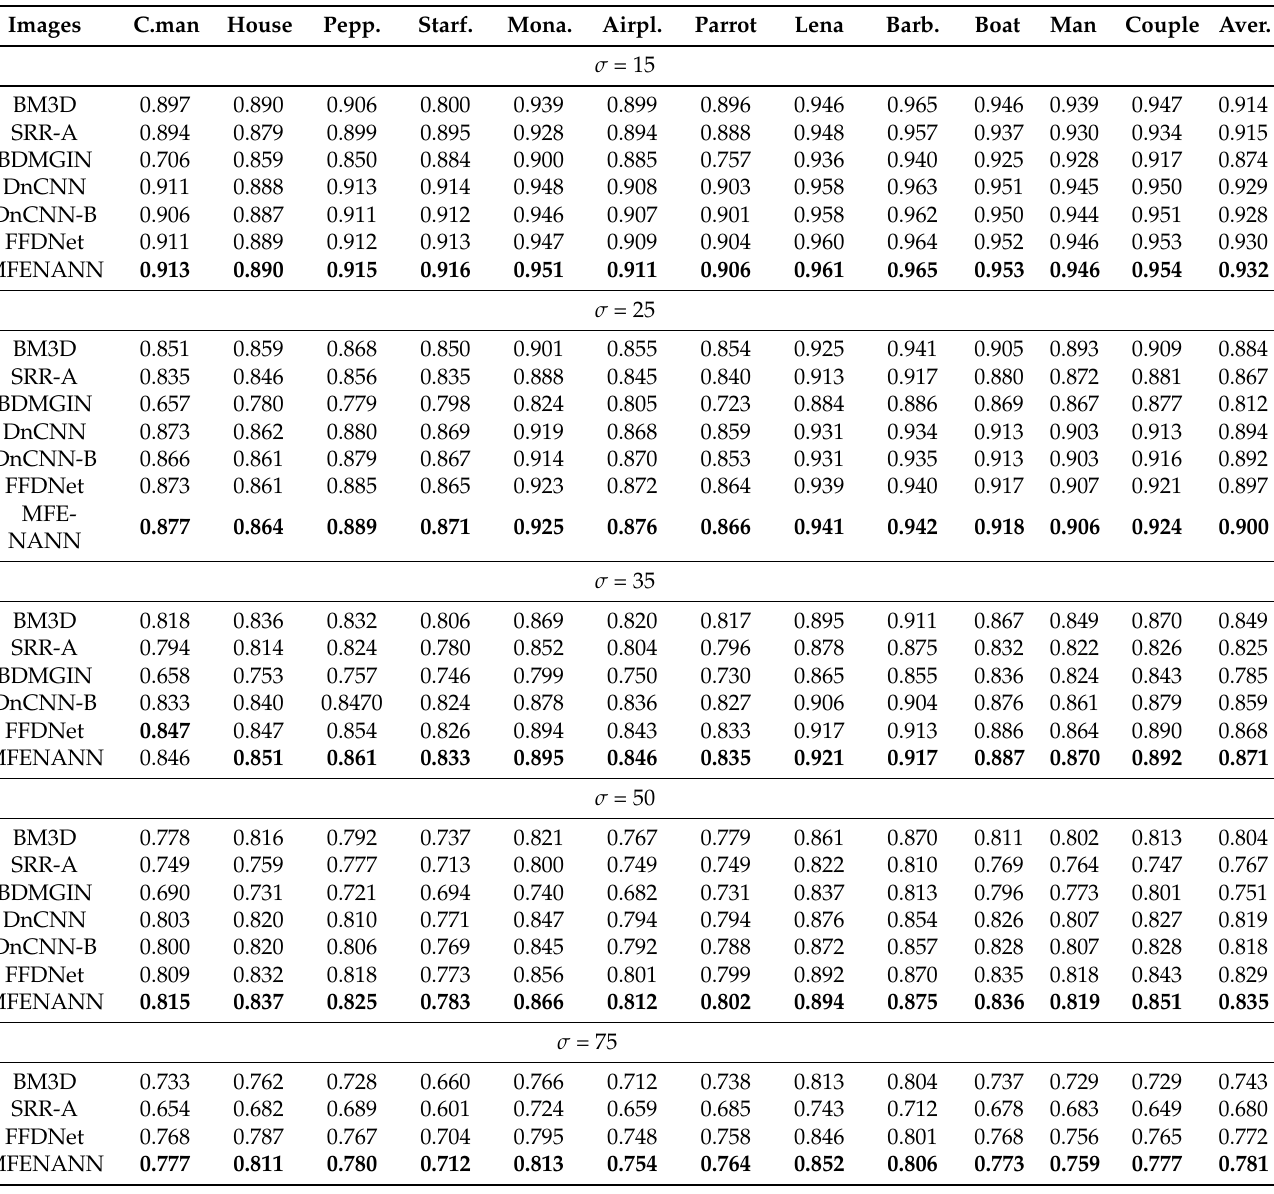
Table 5. The SSIM values for restored images from “Set12” using several state-of-the-art algorithms at noise levels of 15, 25, 35, 50 and 75. The bold numbers are the largest from the corresponding noise levels. Images